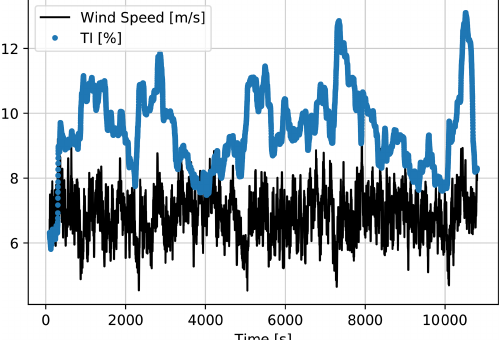
Figure 4. First LSTM model training input time series generated by HAWC2, down-sampled to 1Hz. Mean wind speed = 7ms − 1 ; mean TI = 10%.